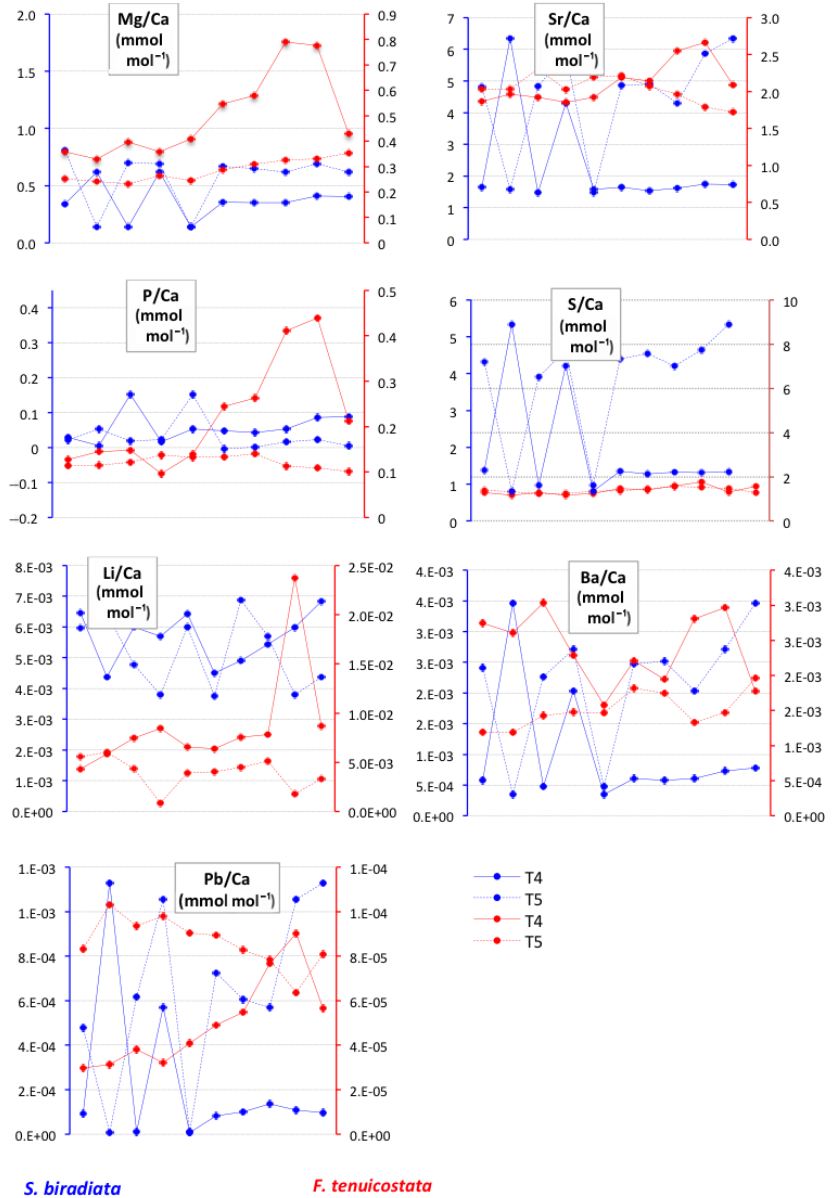
Figure 11. The LA-ICP-MS results for the T4 and T5 transects. The blue lines represent the results for S. biradiata (G171) and the red lines represent the results for F. tenuicostata